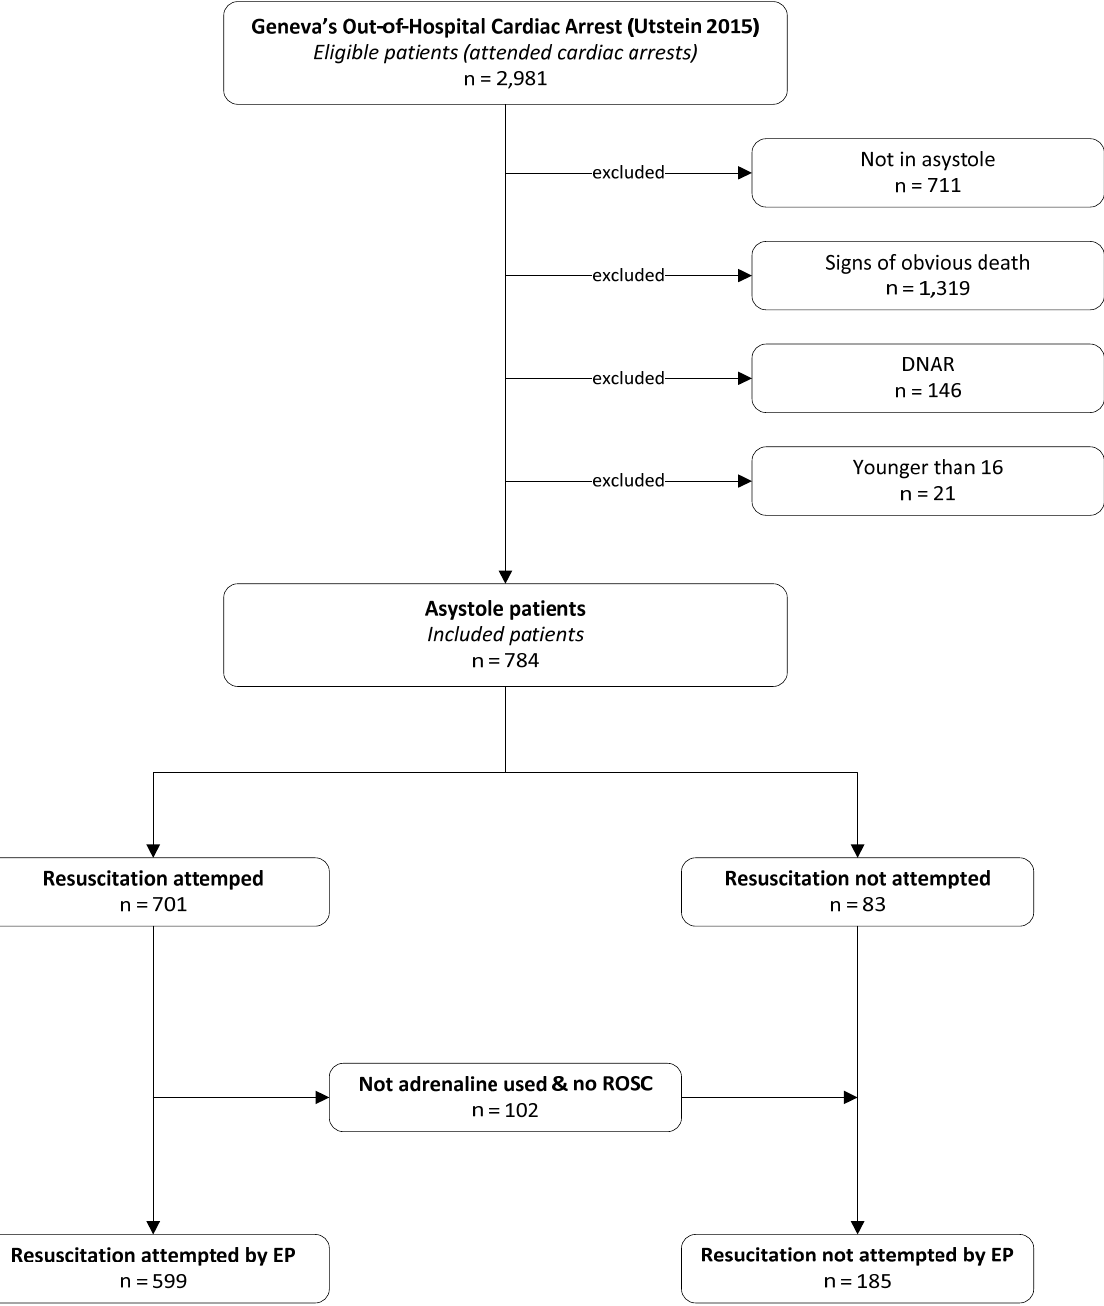
Figure 2. Flowchart of the study.